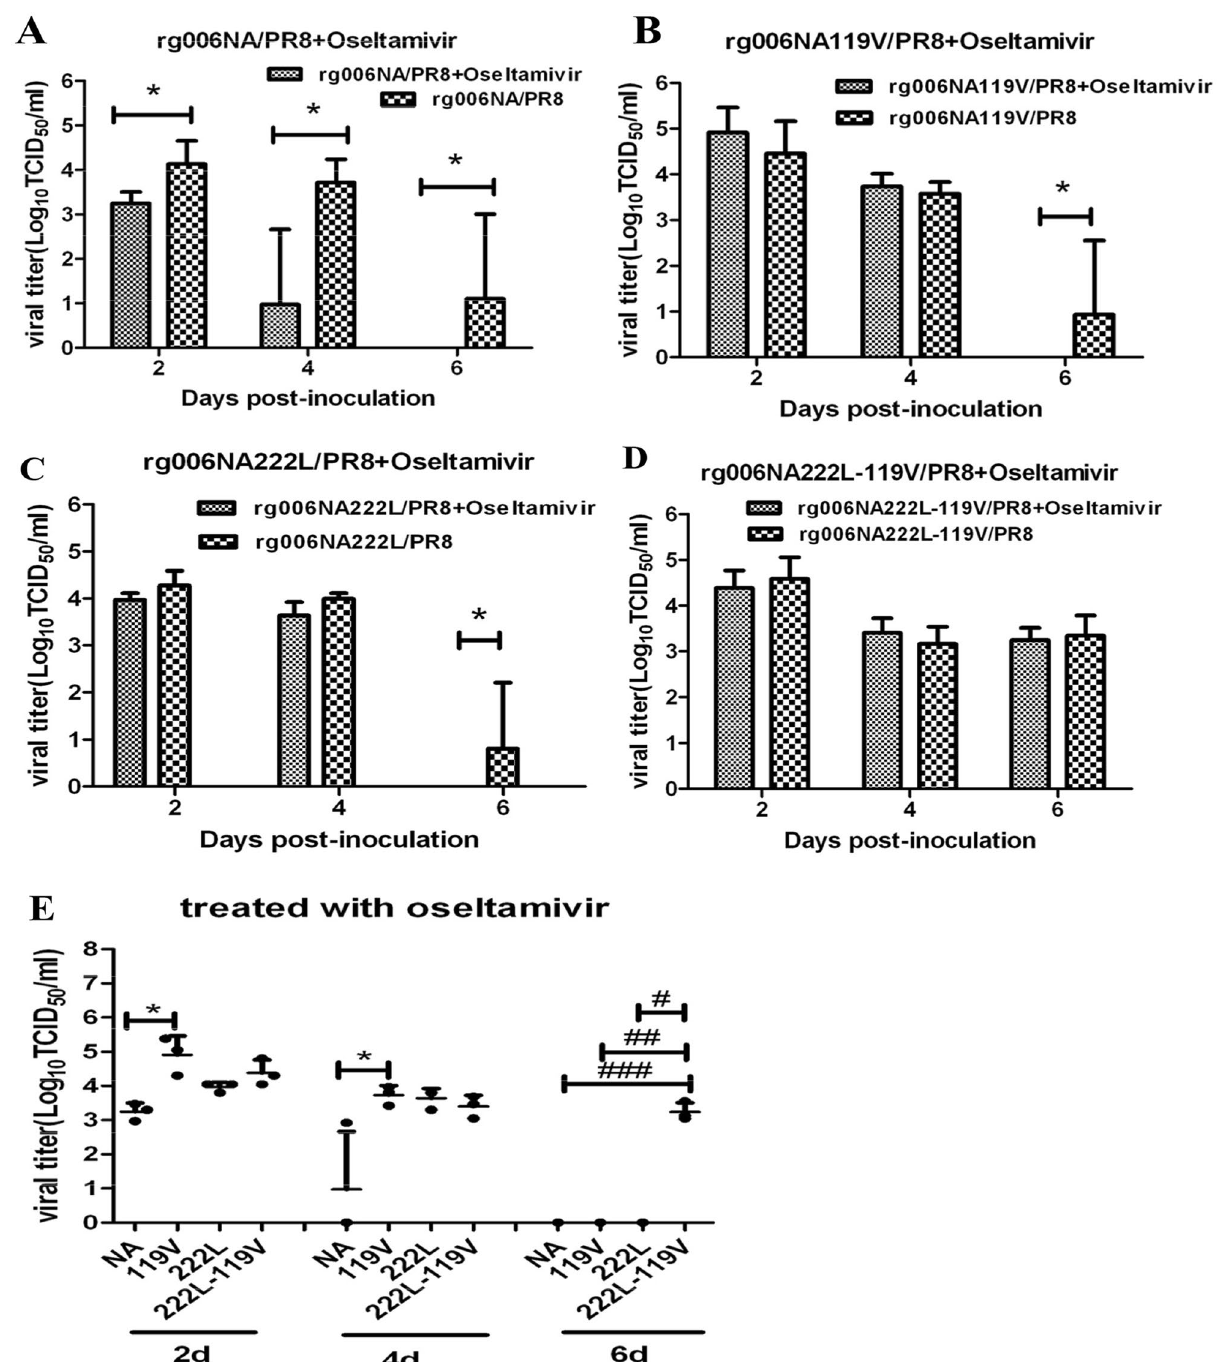
Figure 6. Viral load of lung tissue of mice infected with H7N9/PR8 recombinant viruses treated with oseltamivir phosphate. The lung tissues of C57 mice infected with 2MLD 50 H7N9/PR8 recombinant viruses were titrated 2, 4 and 6 dpi (n = 3/time-point). Mice in the drug treatment group: 20 mg/kg/day oseltamivir phosphate by gavage from 0 to 4dpi; Mice in the non-drug group: PBS by gavage from 0 to 4 dpi. ( A–D ) Comparison of mice infected with H7N9/PR8 recombinant viruses in the drug treatment group or non-drug group. ( E ) Comparison of mice infected with rg006NA/PR8 (NA), rg006NA119V/PR8 (119V) and rg006NA222L-119V/ PR8 (222L-119 V) virus after oseltamivir administration. * P < 0.05. # P < 0.05. ## P < 0.05. ### P <